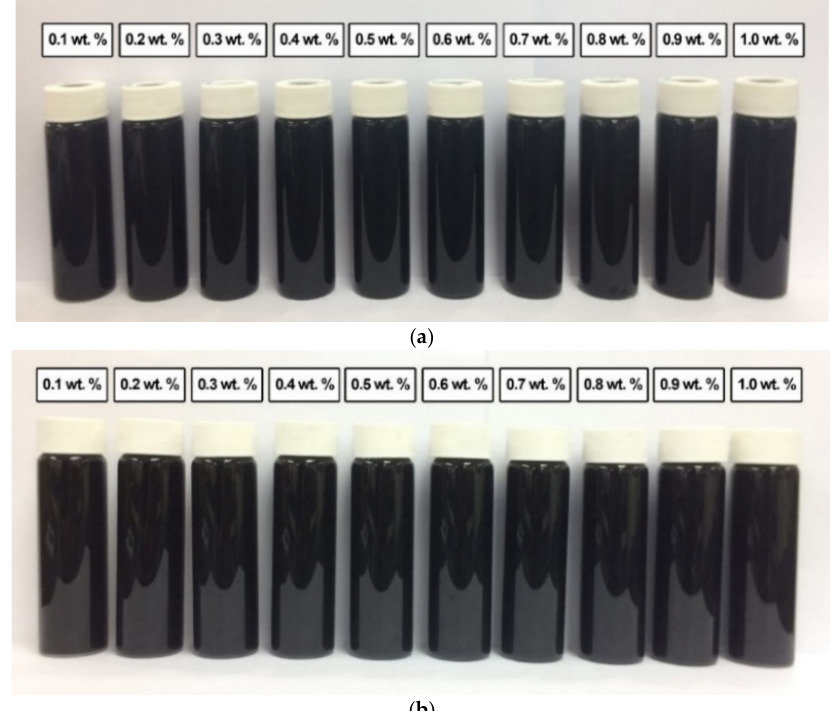
Figure 12. The various surface ‐ oxidised CNF ‐ based nanofluids without PVP after ( a ) 0.5 h and ( b ) 100 h of the homogenisation and sonication process.